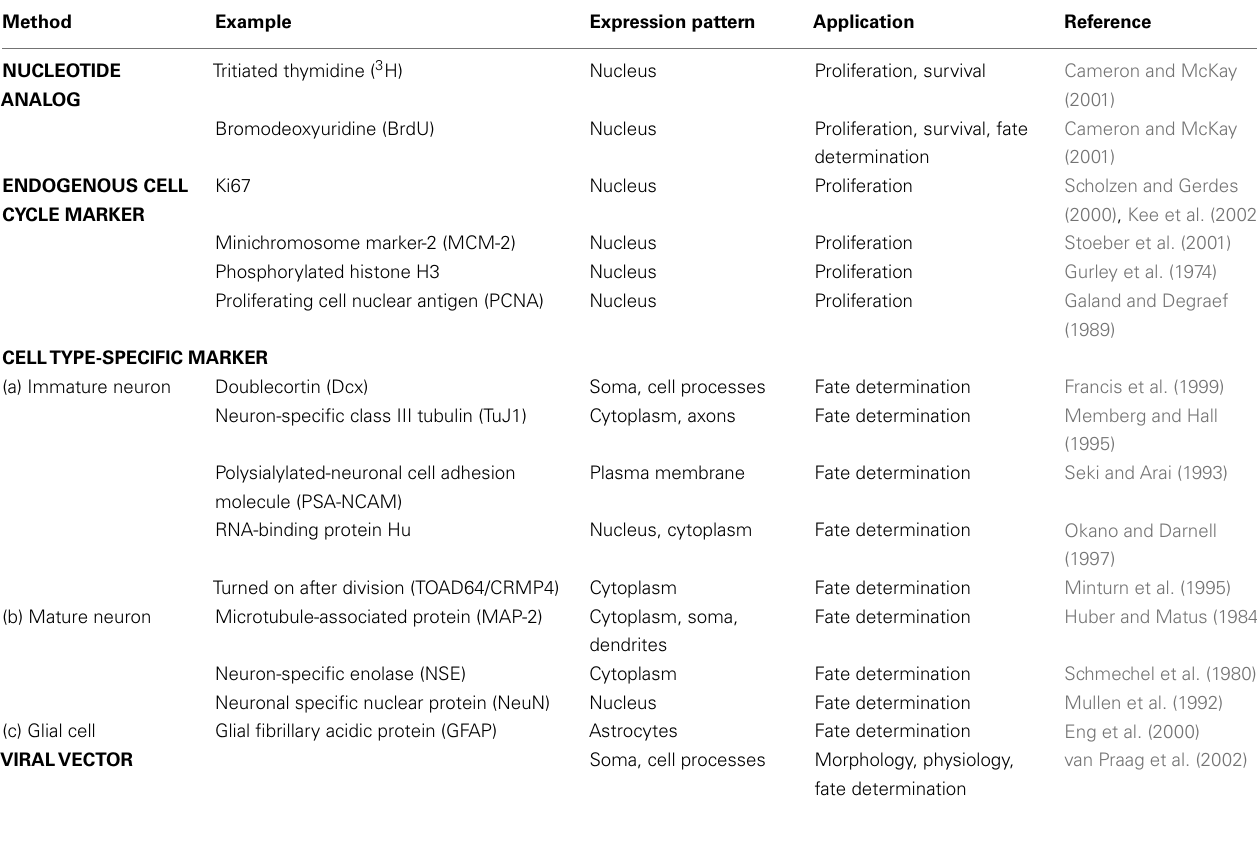
Table 1 | Commonly used methods to study adult